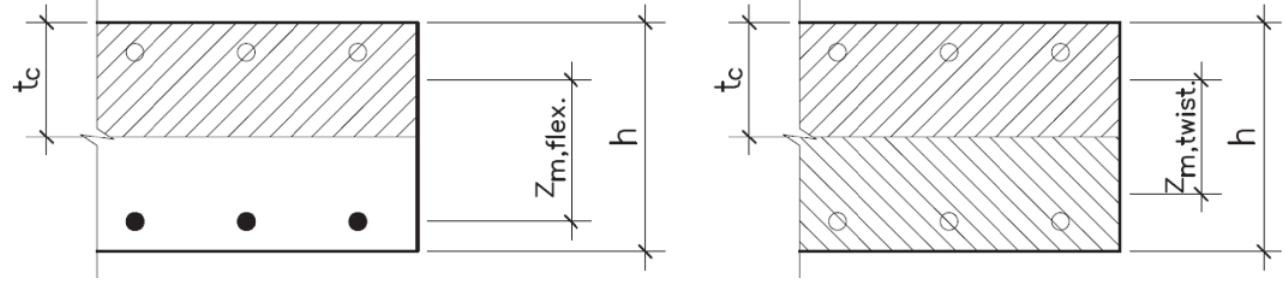
Figure 16 Panel thickness and lever arm